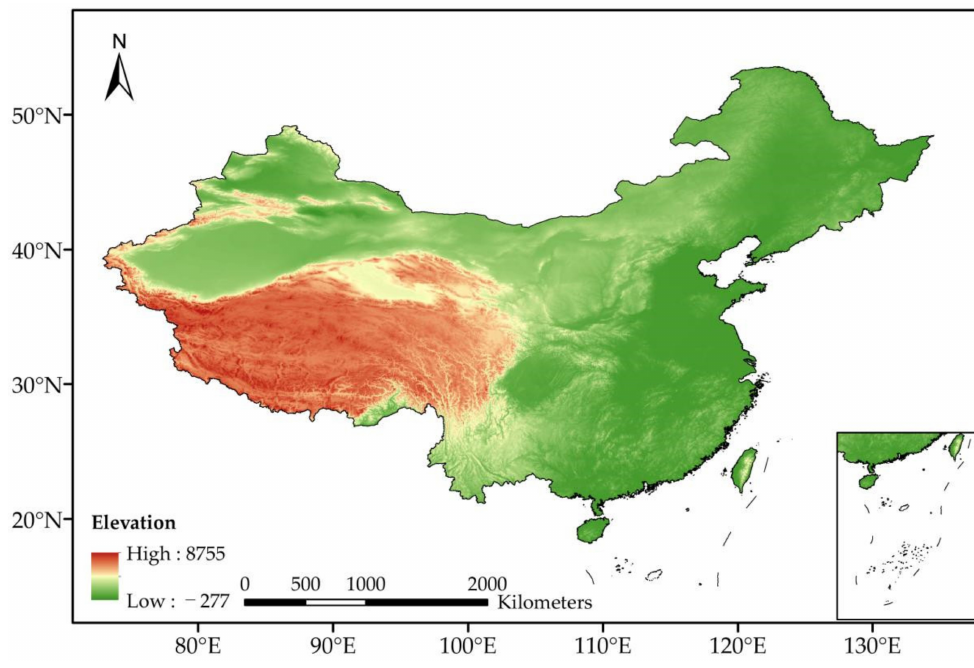
Figure 1. The location of the study